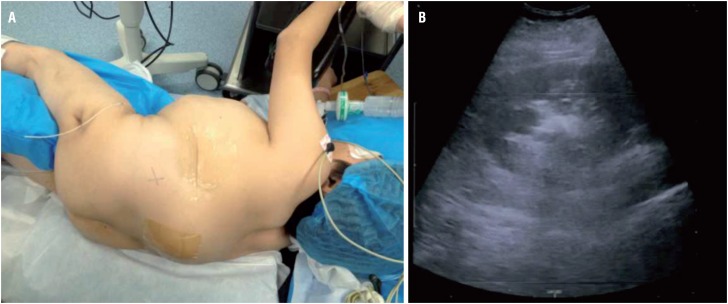
The patient was placed in the lateral decubitus position for the spinal deformity prevented to be placed in the prone position (Figure-2a). A successful US-guided puncture was performed. The dotted line corresponds to the tract of needle (Figure-2b).